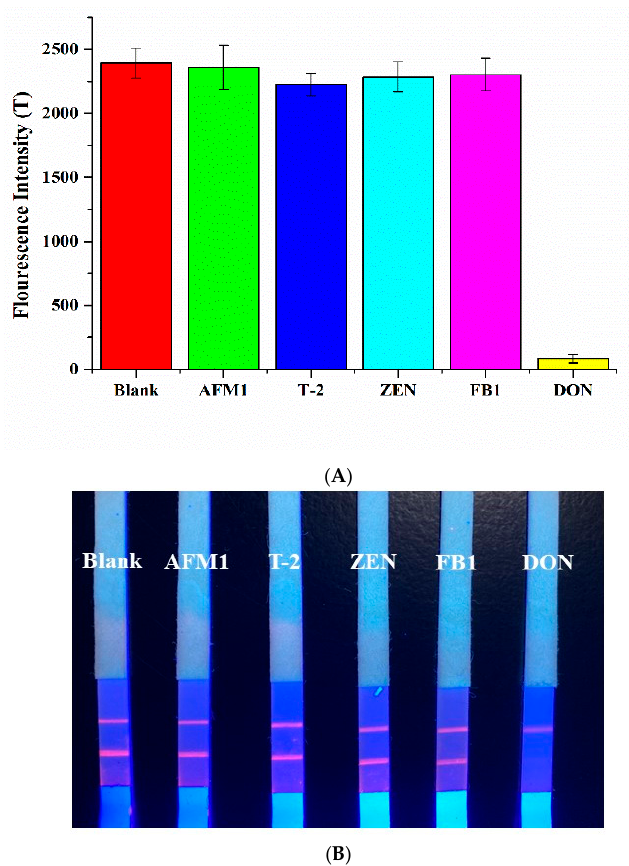
Figure 6. Paper-based sensor specificity evaluation ( A ) and physical images ( B ).